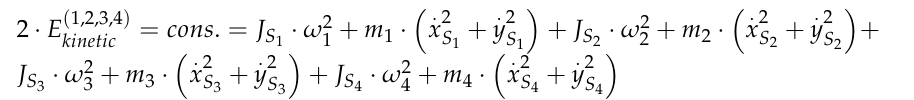
element 4 in the mass center; ω 1 , ω 2 , ω 3 , ω 4 represents the rotational speed of the respective . x element (1, 2, 3, 4); the velocity of the center of mass of element 1 ( S 1 ) projected on the S 1 . . x -axis; y x the velocity of the center of mass of element 1 ( S 1 ) projected on the y -axis; S 2 S 1 . y the velocity of the center of mass of element 2 ( S 2 ) projected on the x -axis; the velocity S 2 . x of the center of mass of element 2 ( S 2 ) projected on the y -axis; the velocity of the center S 3 . y of mass of element 3 ( S 3 ) projected on the x -axis; the velocity of the center of mass of S 3 . x element 3 ( S 3 ) projected on the y -axis; the velocity of the center of mass of element 4 ( S 4 ) S 4 . y projected on the x -axis; the velocity of the center of mass of element 4 ( S 4 ) projected on S 4 the y